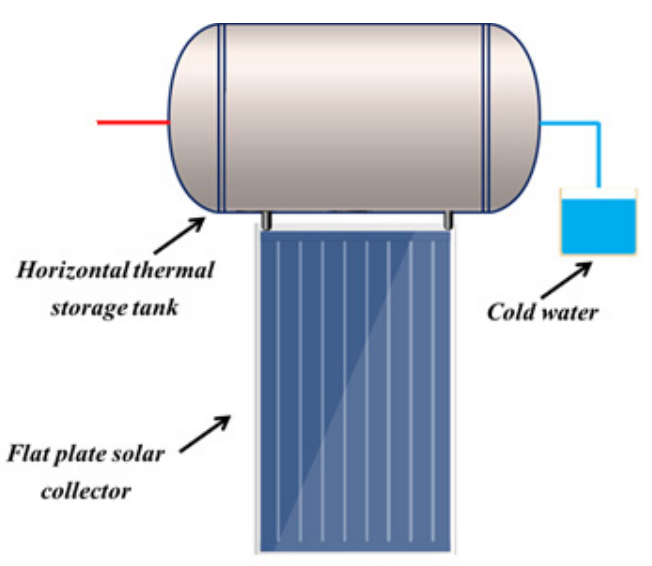
Figure 8. Thermosyphon system schematic.